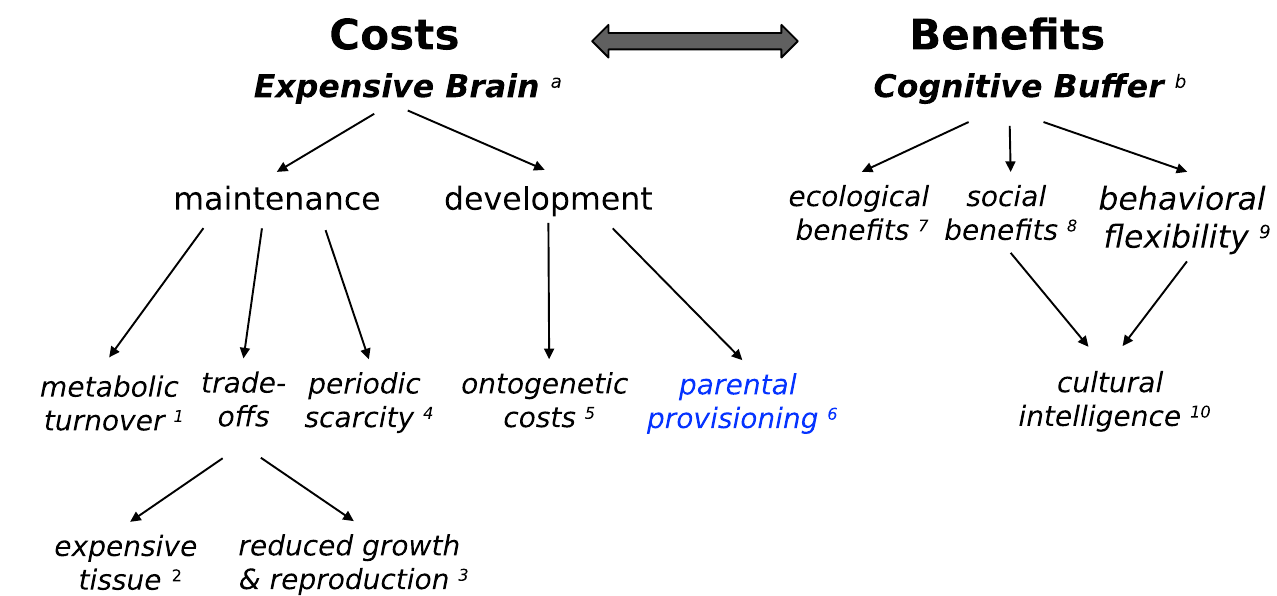
Fig 2. Categorization of the various hypotheses to explain evolutionary variation in relative brain size among vertebrates. Two complementary clusters of hypotheses focus on either costs (expensive brain) or benefits (cognitive buffer). The brain size of a given species should reflect the balance between all relevant processes. In this review, we elaborate the developmental aspects of the expensive brain hypothesis. Key references are provided in superscripts: a: [124] (see also delayed benefits: [125]; b: [30]; 1: metabolic demands: [126,127]; 2: [45]; 3: [29, 30]; 4: [128,129]; 5: [55] (see also maturational constraints and brain malnutrition risks: [125]); 5: [83,88,108](also: maternal energy); 7: [130,131];8: [132,133]; 9: [22]; 10: